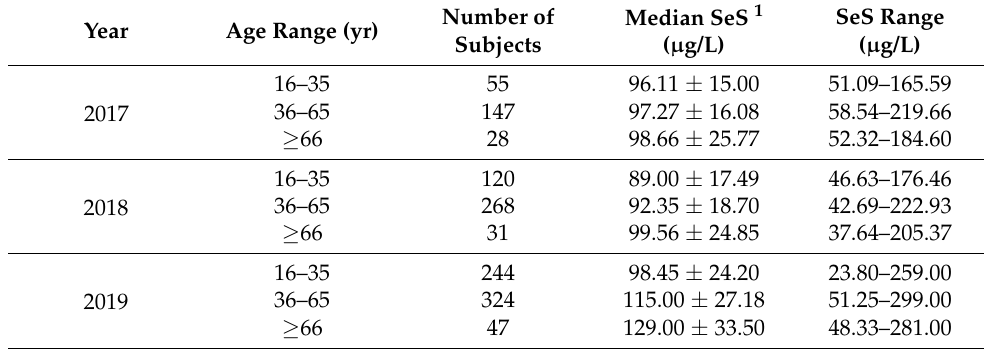
Table 1. Range and median of SeS concentrations in all subjects from Western Romania by age.